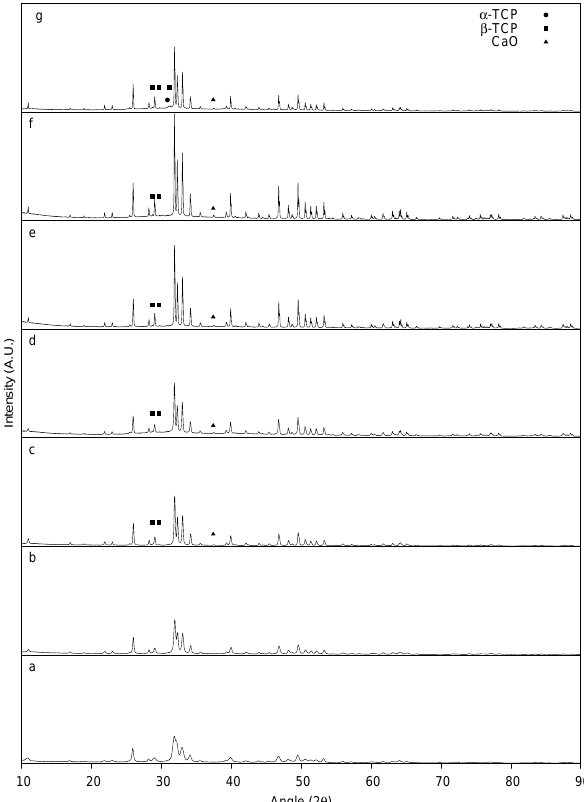
Figure 2. Powder XRD pattern of as-synthesized HA ( a ) and HA heat treated at: 800 °C ( b ); 900 °C ( c ); 1000 °C ( d ); 1100 °C ( e ); 1200 °C ( f ); and 1300 °C ( g ). Non-labeled peaks correspond to observed reflections from pure HA.